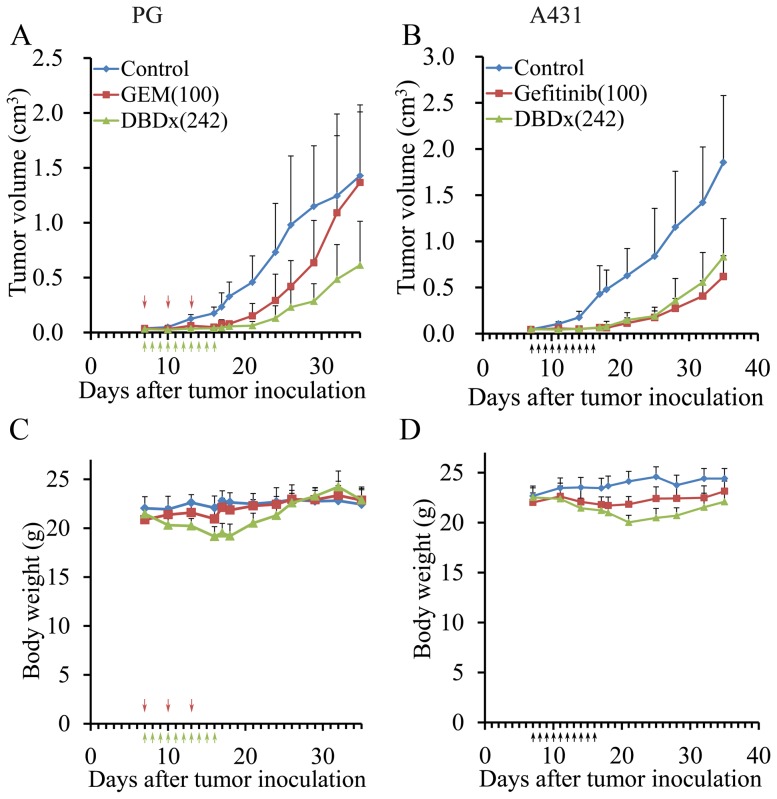
Comparison of antitumor efficacy of DBDx with GEM in PG xenograft model and gefitinib in A431 xenograft model.
A. DBDX showed stronger antitumor activity than GEM in PG xenograft model. B. DBDX showed similar antitumor activity with gefitinib in A431 xenograft model. C. The body weights of PG xenograft-bearing mice during treatment. D. The body weights of A431 xenograft-bearing mice during treatment. (Dose: mg/kg).